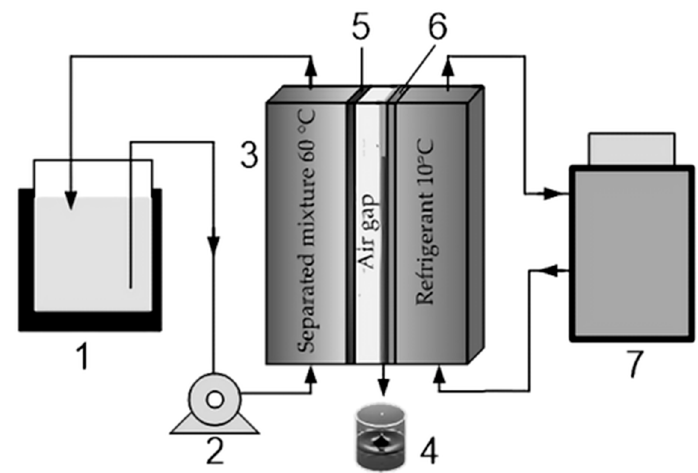
Figure 2. The scheme of a TPV unit: 1—a thermostat with a separable mixture; 2—a peristaltic pump; 3—a membrane module; 4—a permeate collector; 5—a membrane, 6—a metal condensation surface; and 7—cryothermostat.